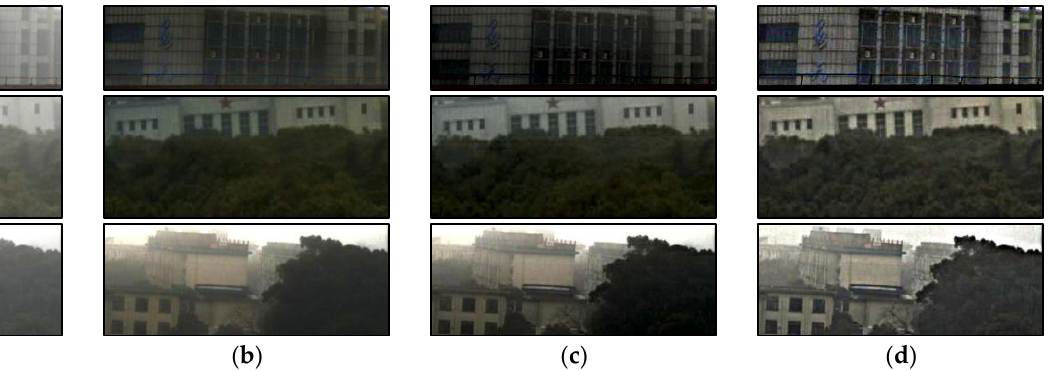
Figure 8. The comparison of the enlarged details, ( a ) the original image, ( b ) the result of dark channel, ( c ) the result of SIDMP, ( d ) the result of proposed.